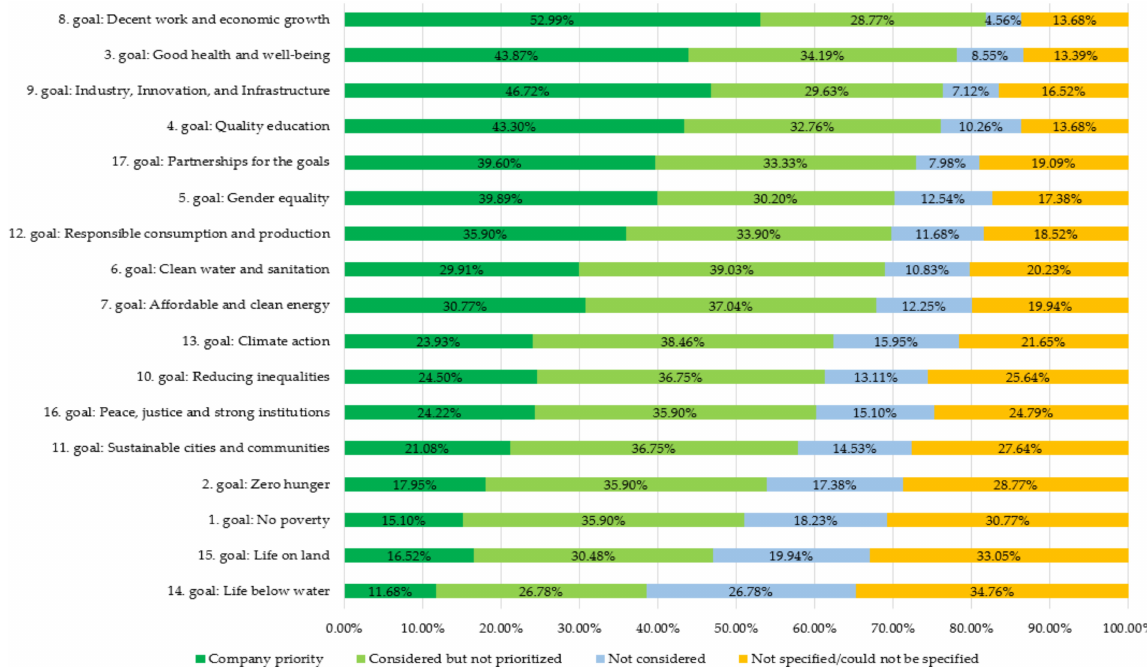
Figure 2. The identified orientation toward specific SDGs in sample enterprises for the overall